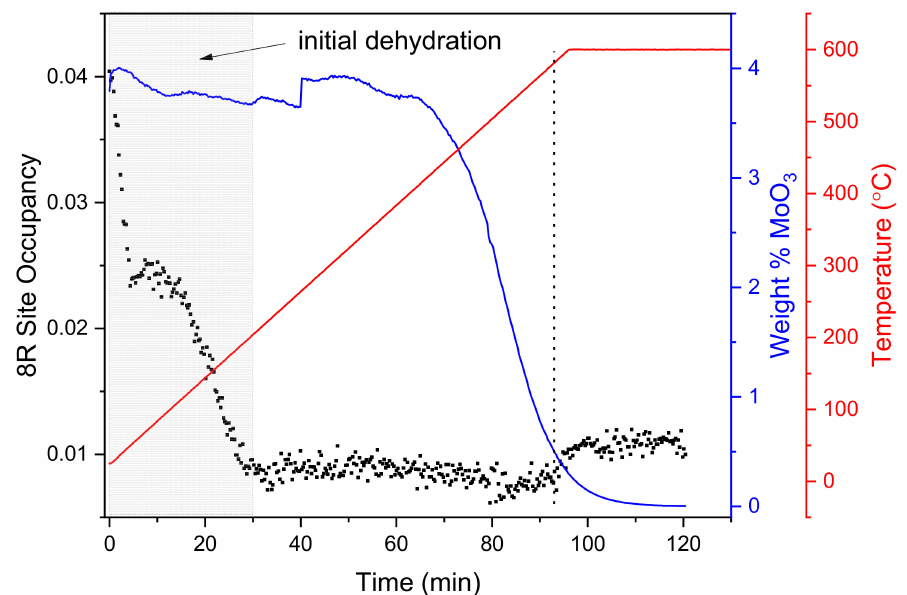
Figure 1. Synchrotron powder di ff raction (SPD) results for MoO 3 and H-SSZ-13 physical mixture showing the Mo occupancy in the 8-membered ring (8R) position of the CHA structure (black dots) during calcination (room temperature to 600 ◦ C in 20% O 2 / He). The wt % of crystalline MoO 3 precursor (blue line) during calcination and the sample temperature (red line) are indicated in the right axes. The region of the experiment in which water is leaving the zeolite framework (up to ≈ 200 ◦ C) is indicated by grey shading, the dotted vertical line indicates the point where the 8R site occupancy begins to increase as the wt % of MoO 3 decreases.